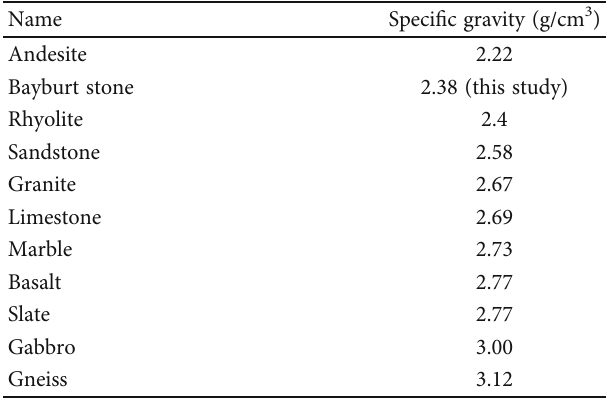
Table 1: Average speci fi c gravity of various stone types. Name